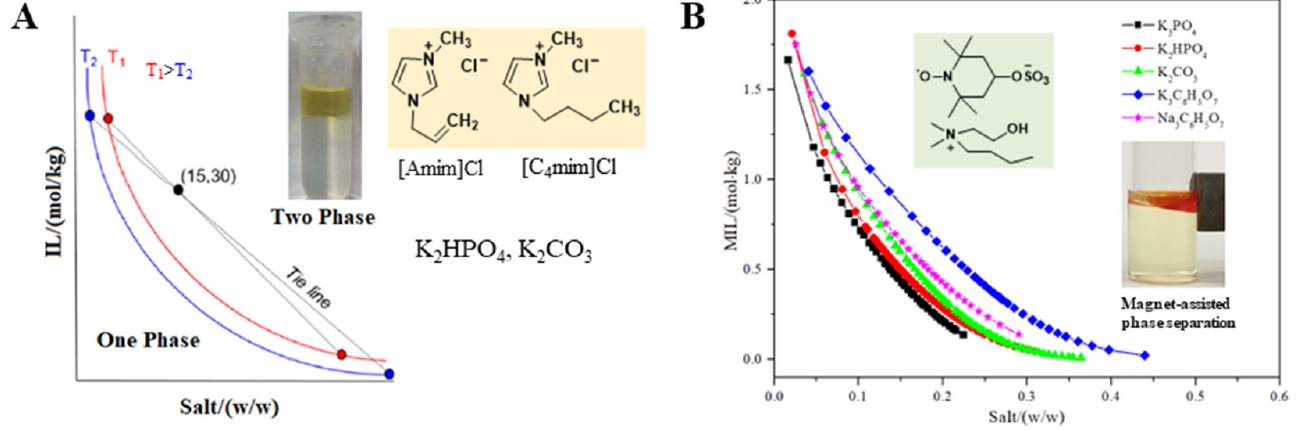
Figure 4. Effect of different salts on phase equilibrium behavior of imidazolium-based IL ATPS ( A ) and cholinium-based MIL ATPS ( B ) [103].